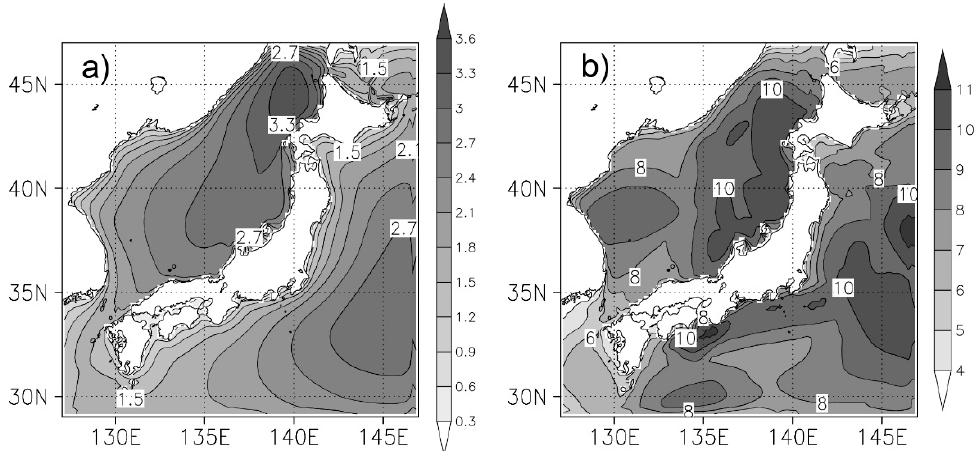
H ) for s H ) for s